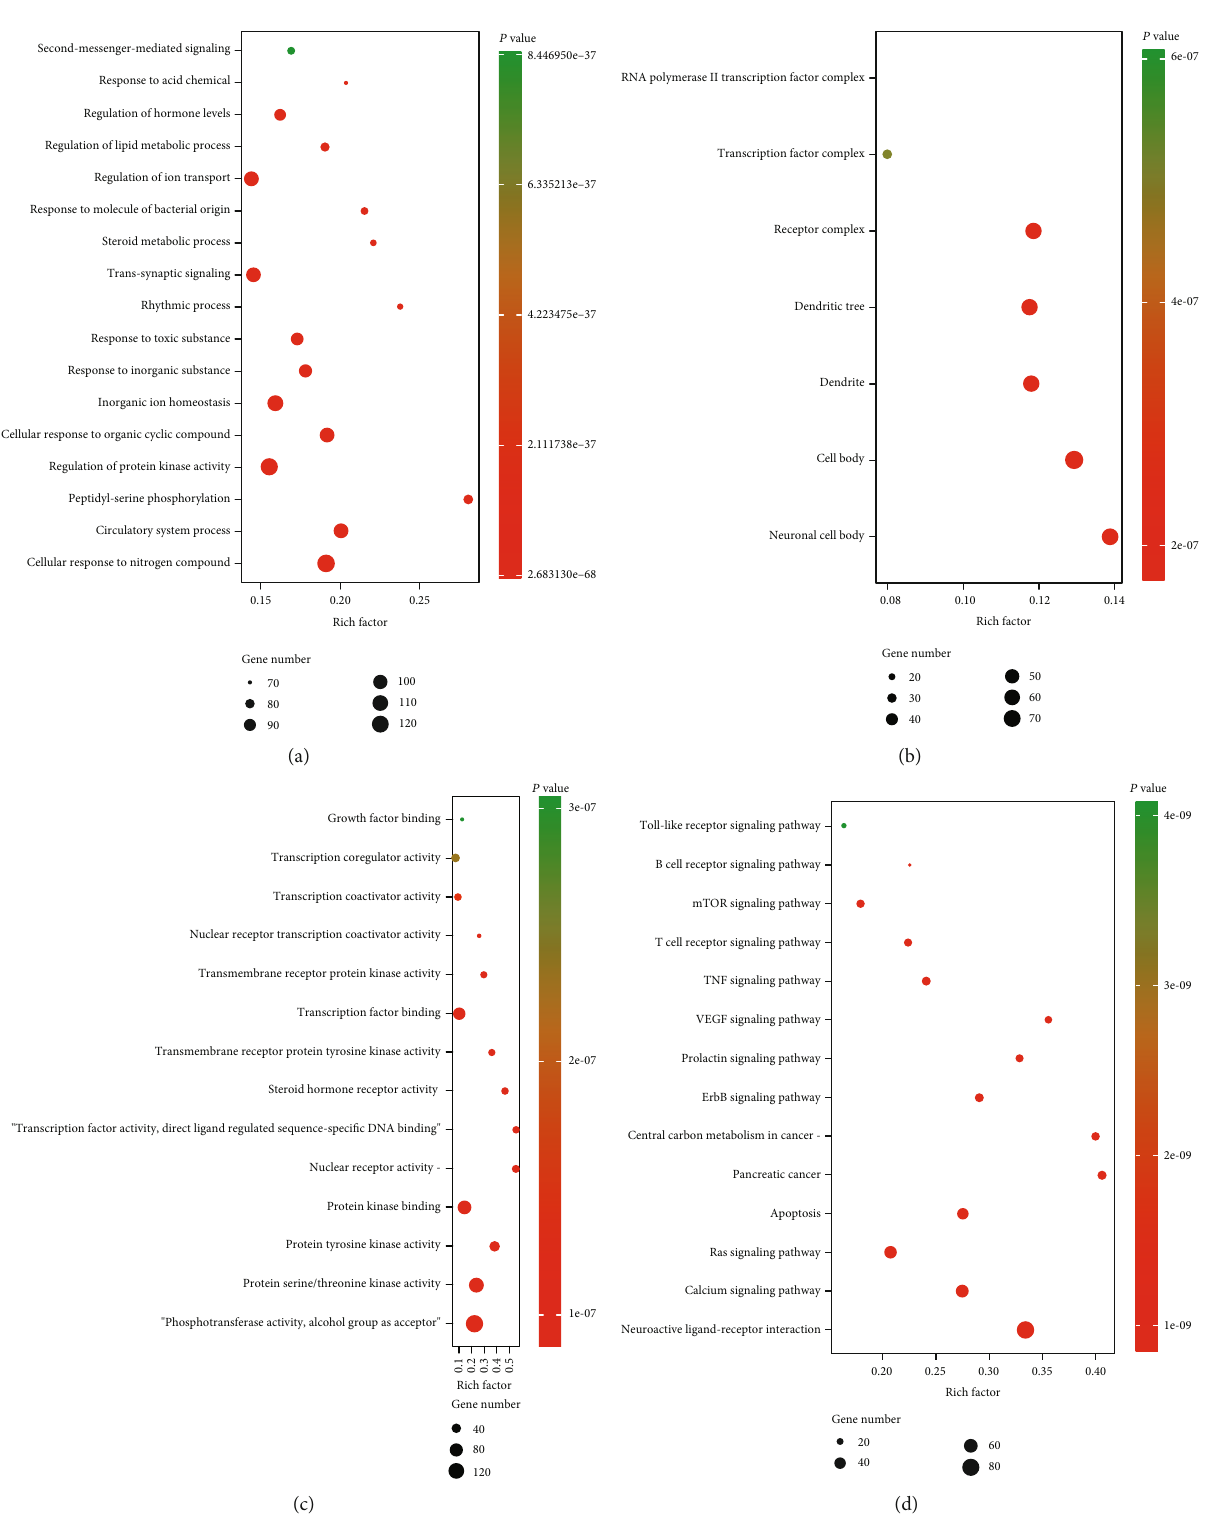
Figure 2: Functional annotation of active ingredients related to putative targets. (a) Enriched biological processes. (b) Enriched cellular components. (c) Enriched molecular functions. (d) Enriched KEGG component. Phosphotransferase activity-alcohol group as (Figure 2(a)). According to the results in Figure 2(b), the acceptor, protein serine/threonine kinase activity, and tran- putative targets were most signi fi cantly enriched in the neu- scription factor binding of molecular function (Figure 2(c)). ronal cell body, dendrite, receptor complex of GO cellular